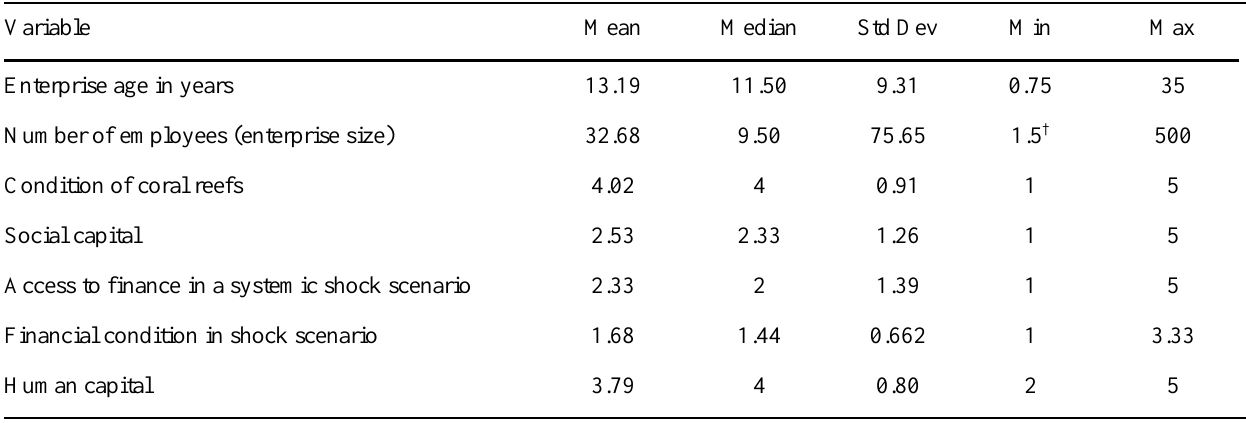
Table 4. Absolute and relative frequencies for the binary variables.